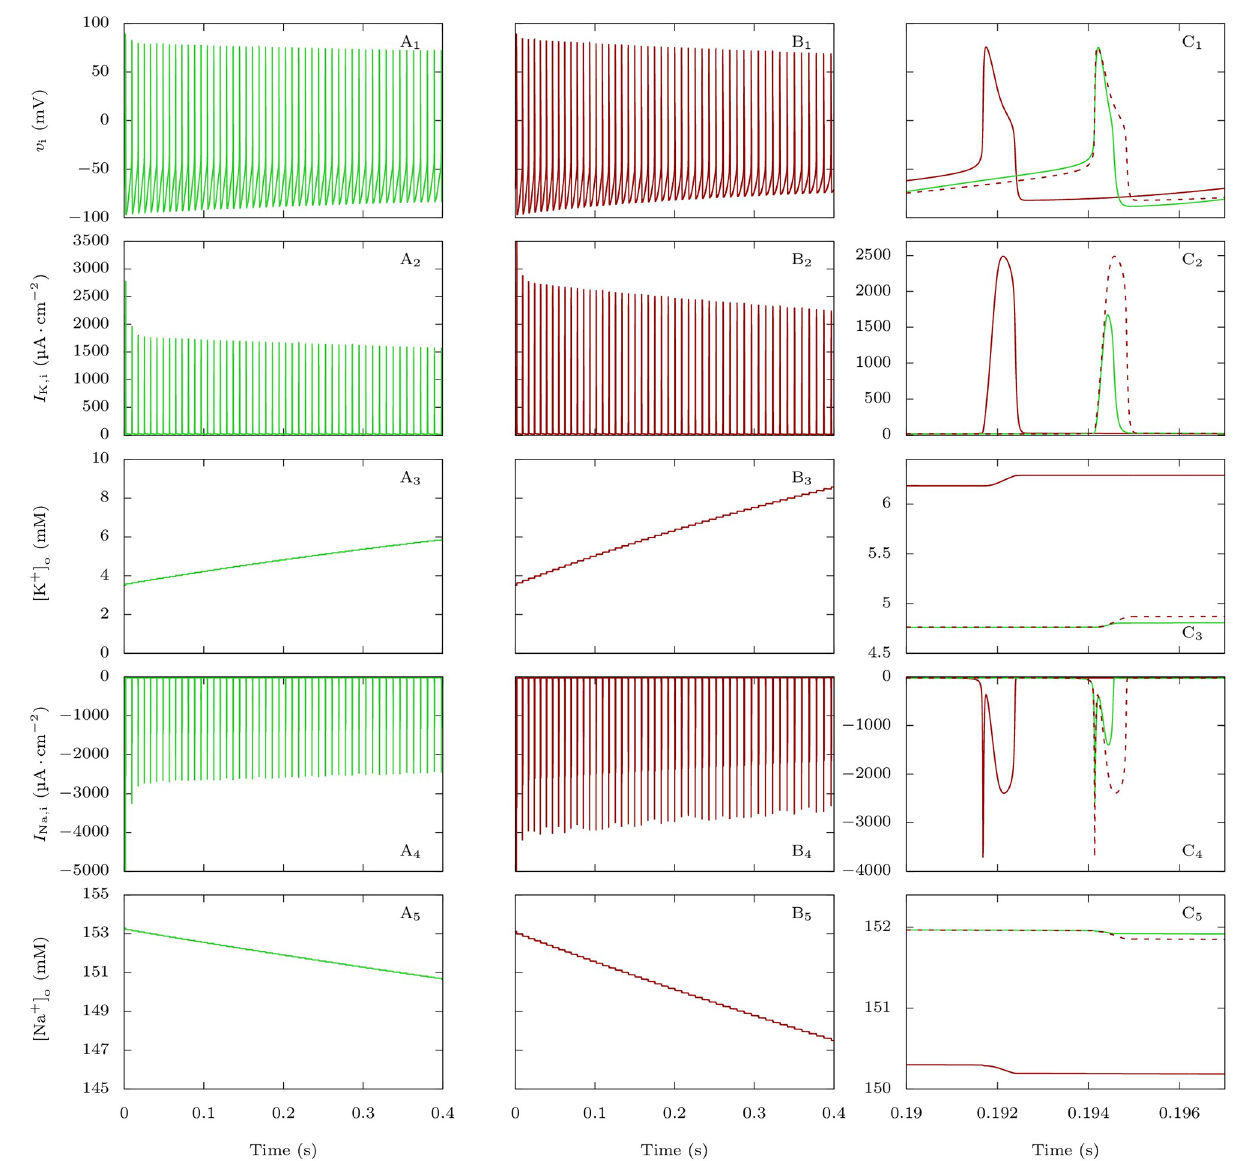
Fig 3. Effect of FHM-3 mutations on the firing and action currents of the GABAergic neuron, and correlation with the dynamics of [K + ] o and [Na + ] o . Plots of the voltage (action potentials; upper row), total potassium current (second row), extracellular potassium concentration (third row), total sodium current (fourth row) and extracellular sodium concentration (bottom row) corresponding to simulations displayed in Fig 2, for the condition in which g D,i = 0.3 mS � cm − 2 . A : No persistent sodium current: p Na,P = 0%. B : p Na,P = 20%. C : Zoom showing the 25 th action potential of A (in green) and B (in red). The dashed lines are the curves obtained with p Na,P = 20% shifted to allow a better comparison with the curves obtained with p Na,P =